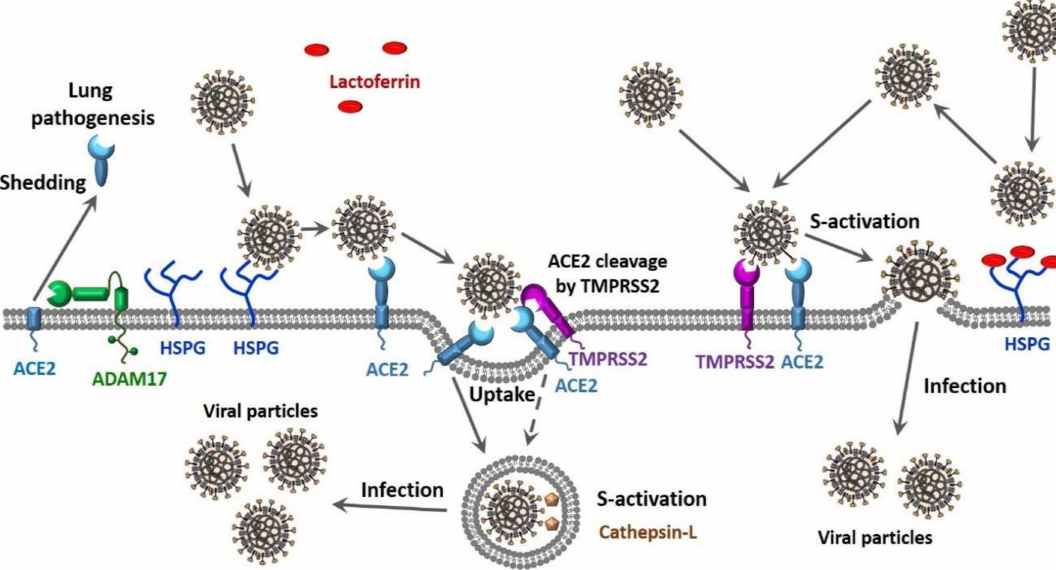
Figure 1. Suggested scenarios for severe acute respiratory syndrome coronavirus 2 (SARS-CoV-2) cellular entry pathways and their potential e ff ects on the viral load and transmission